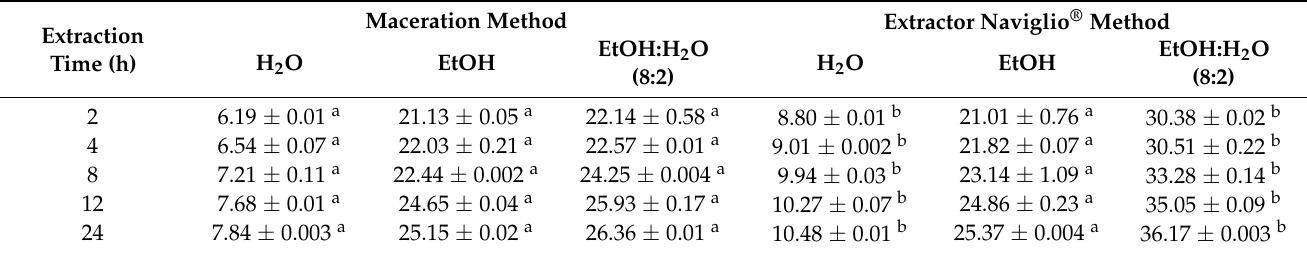
Table 2. Total phenolic compound content (TPC) of the different OFP extracts (expressed in mg GAE · g − 1 extract). Values are presented as mean (triplicate) ± SD. Different superscripts letters indicate significant differences between methods parameters at p <